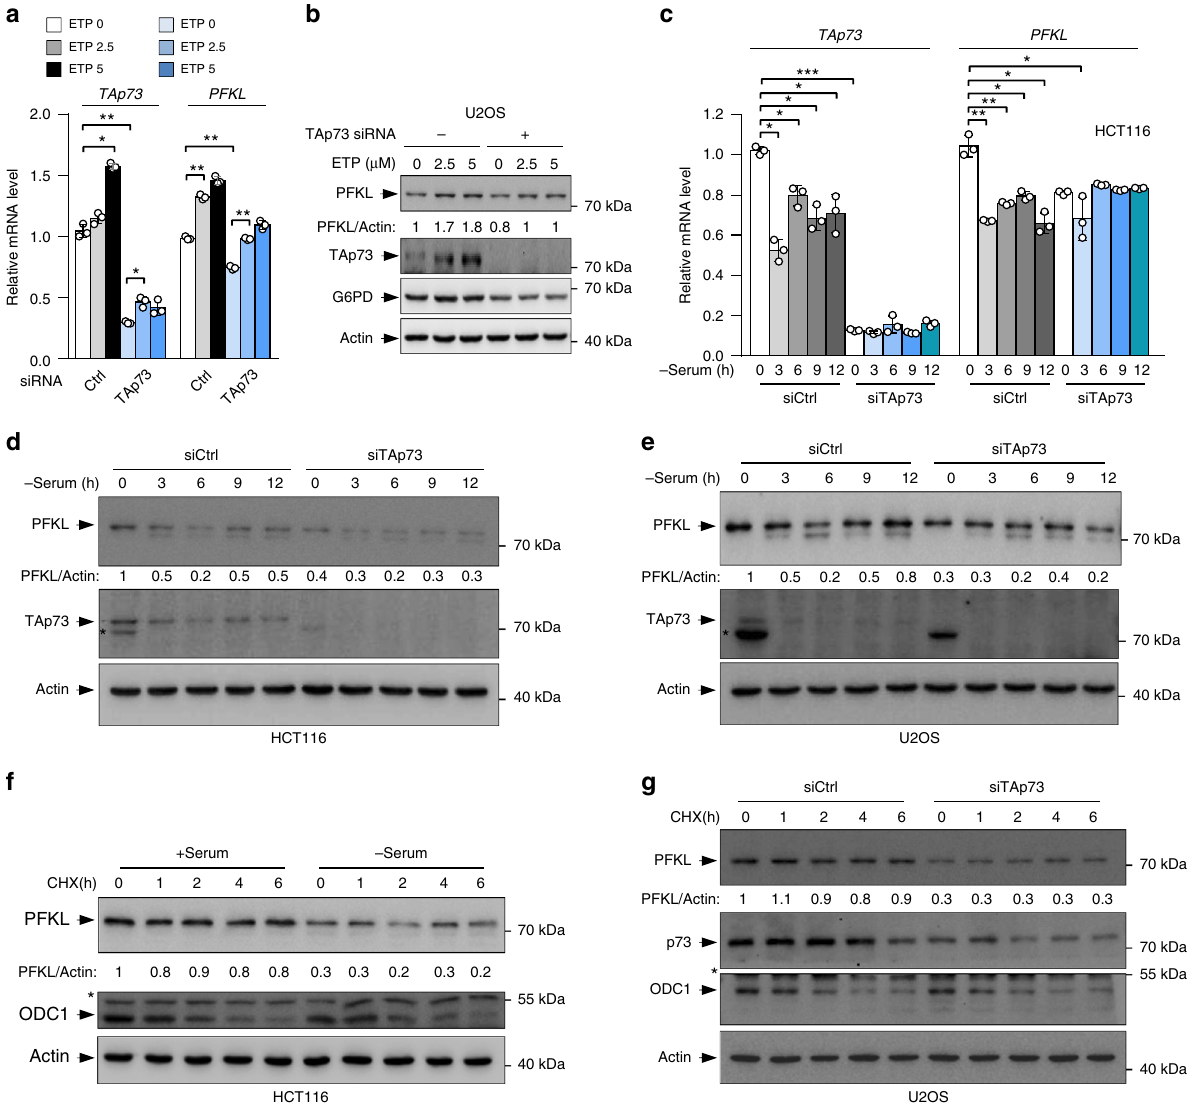
Fig. 3 TAp73 regulates PFKL under stressed conditions. a , b U2OS cells transfected with control or TAp73 siRNA were treated with increasing amounts of etoposide (ETP) for 24 h, and analyzed by qRT-PCR ( a , means ± S.D., n = 3) and Western blot ( b ). Data are representative of three independent experiments. c – e HCT116 ( c , d ) and U2OS ( e ) cells transfected with control siRNA or TAp73 siRNA were cultured in complete medium for 24 h and then in serum-free medium for different times. Cells were analyzed by qRT-PCR ( c , means ± S.D., n = 3) and Western blot ( d , e ). f HCT116 cells were cultured in medium containing serum or no serum for 3 h, and then subjected to cycloheximide (CHX) chase in the presence or absence of serum. Whole cell extracts were collected using a pellet buffer as described previously 32 . Data are representative of three independent experiments. g U2OS cells transfected with control siRNA or TAp73 siRNA were subjected to CHX chase. Data are representative of three independent experiments